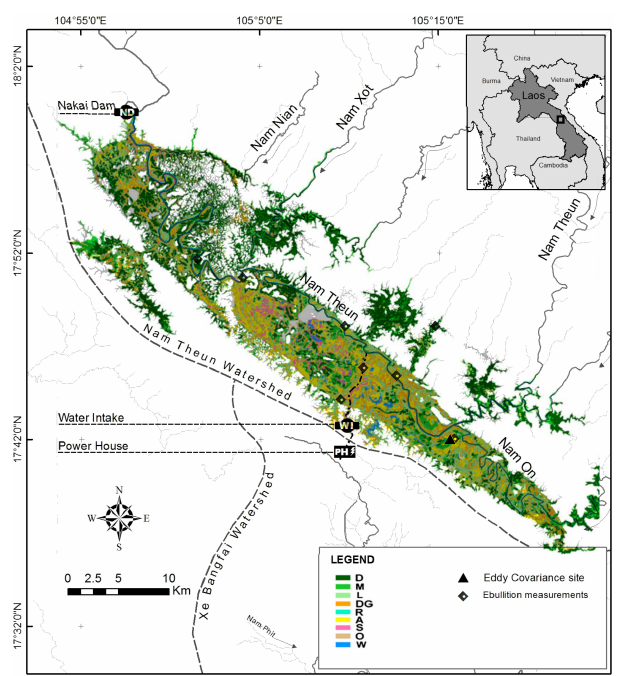
Figure 1. Map of the Nam Theun 2 hydroelectric reservoir (Lao People’s Democratic Republic) showing (1) the land cover before flooding (from Descloux et al., 2011), with D: dense forest, M: medium forest, L: light forest, DG: degraded forest, R: riparian for- est, A: agricultural soils, S: swamps, O: others and W: water, and (2) the location of the ebullition measurements and the eddy covariance site.